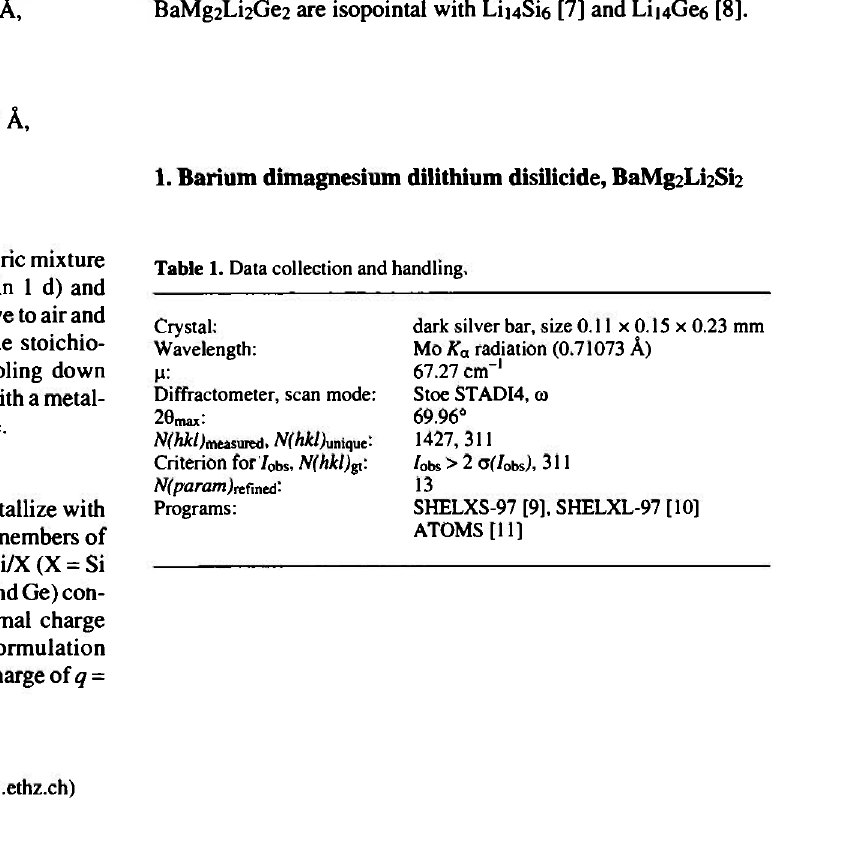
Table 1. Data collection and